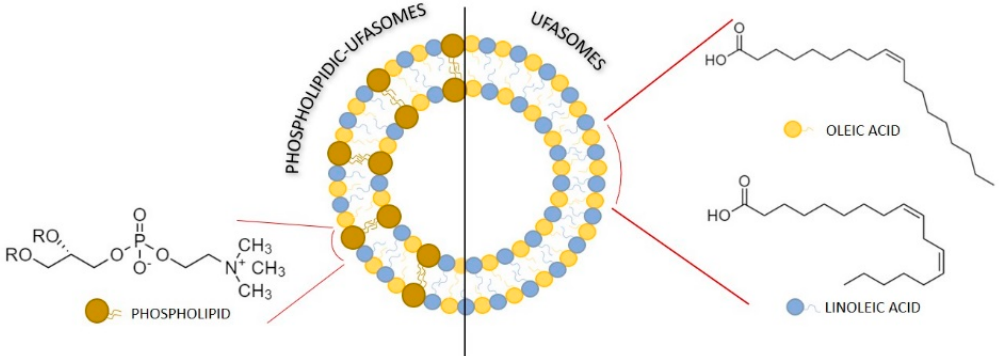
Figure 3. Structural model of a self-assembled ufasomes made of phospholipids and/or unsaturated fatty acids.